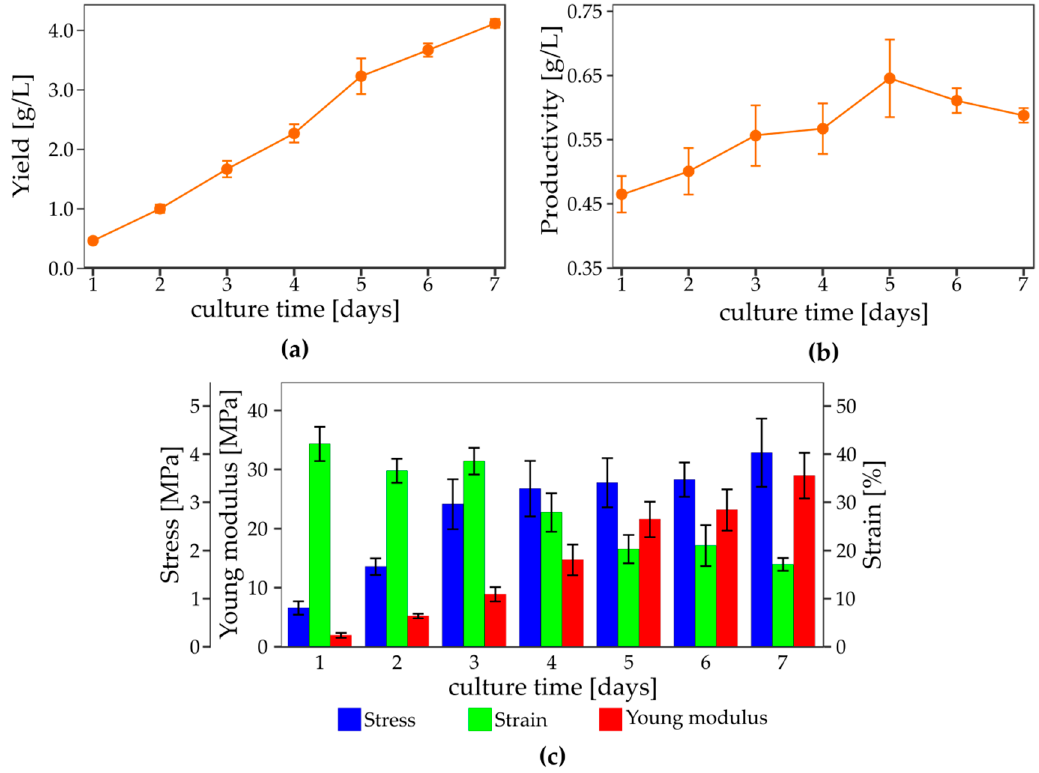
Figure 9. Impact of culture time on ( a ) biosynthesis yield, ( b ) productivity, and ( c ) tensile parameters of bacterial nanocellulose.